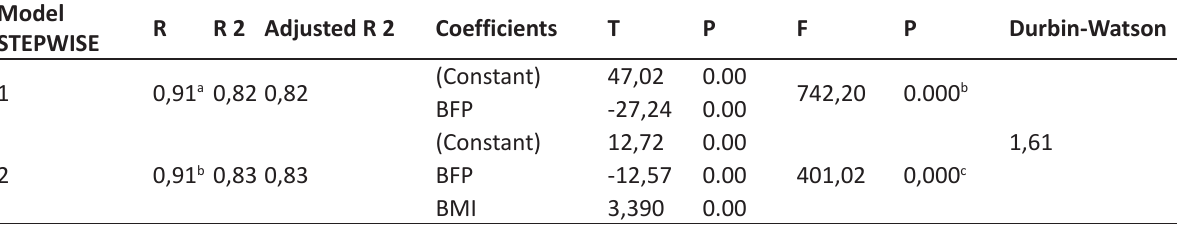
Table 3: Presents the Results of regression analyses relating standing balance (SB) and the anthropometrics variables used in the current